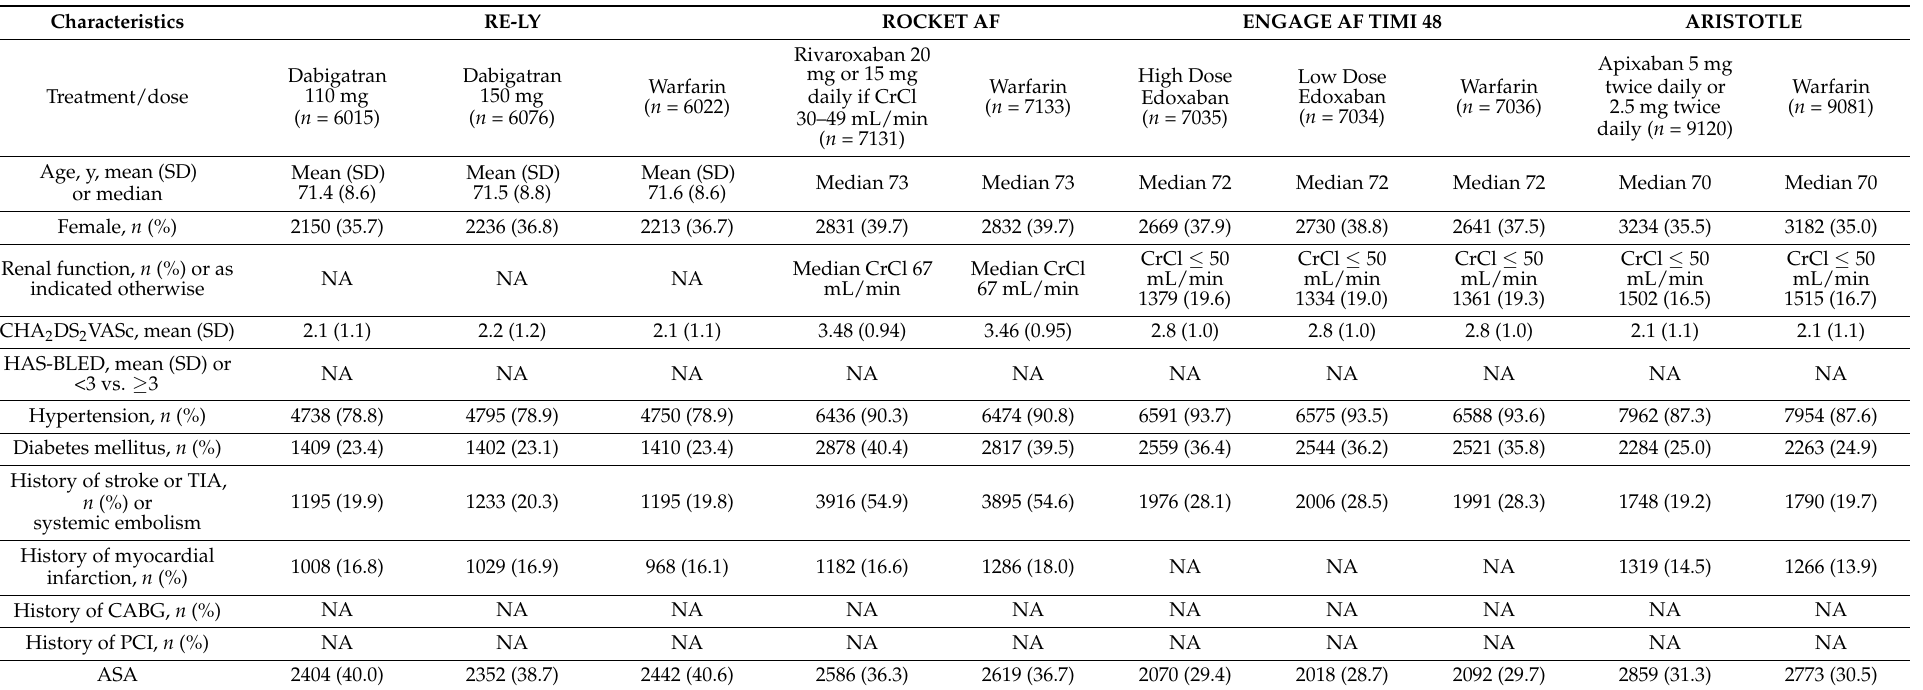
Table 1. Characteristics of patients in clinical trials included in the meta-analysis and not treated with